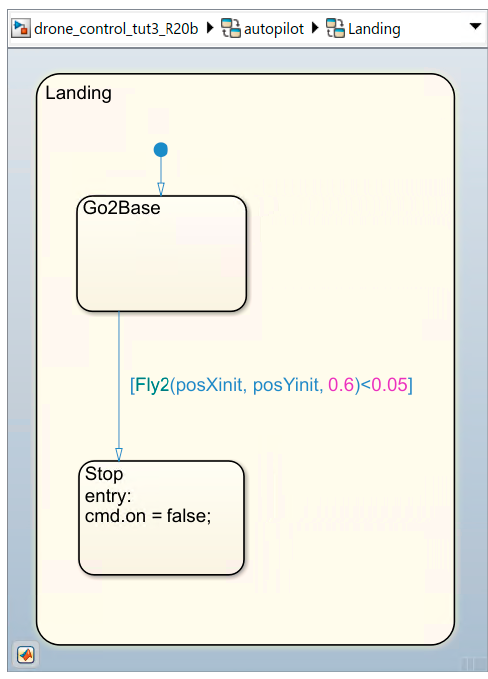
Figure 14. Landing Stateflow state.